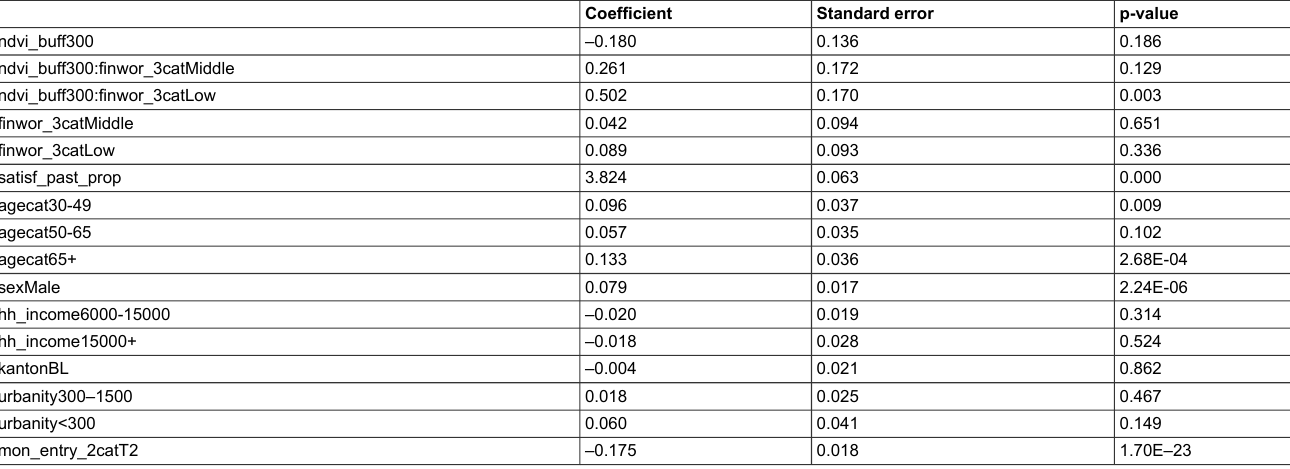
Table 4: Moderation by financial worries (likelihood ratio test p-value = 0.014). Results from Beta regression of life satisfaction on NDVI by financial worries, adjusted for life satisfaction in the past, age categories, sex, household income, canton, degree of urbanisation, and month of entry.